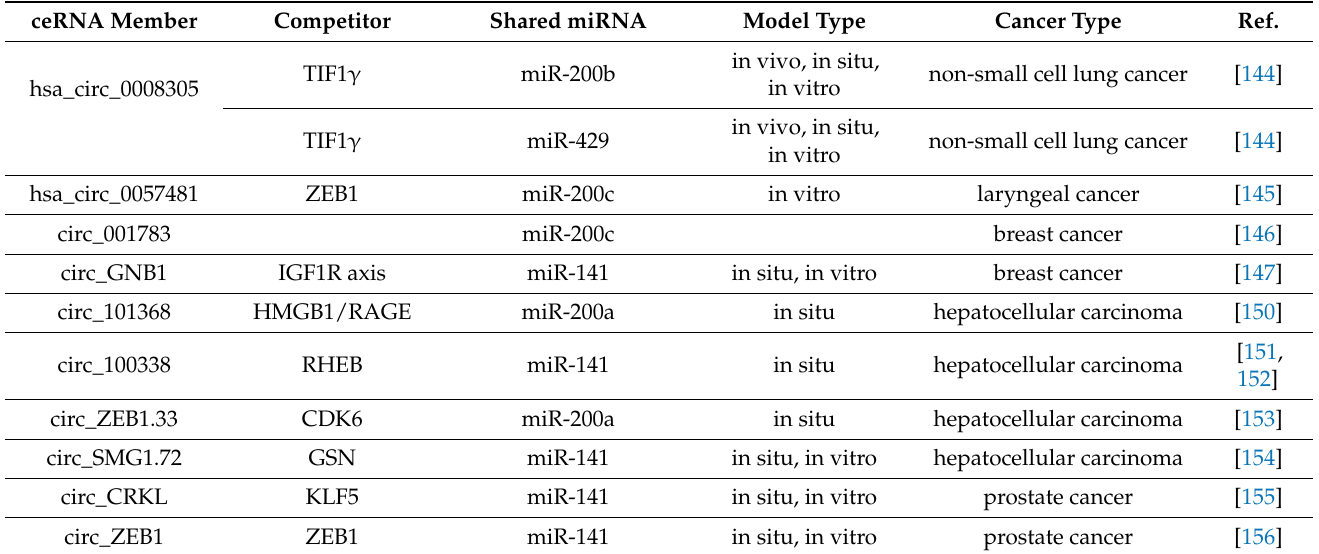
Table 3. Members of circRNA–miRNA–mRNA ceRNA for miRNAs in subgroup I and subgroup II. ceRNA Member Shared miRNA Model Type Cancer Type